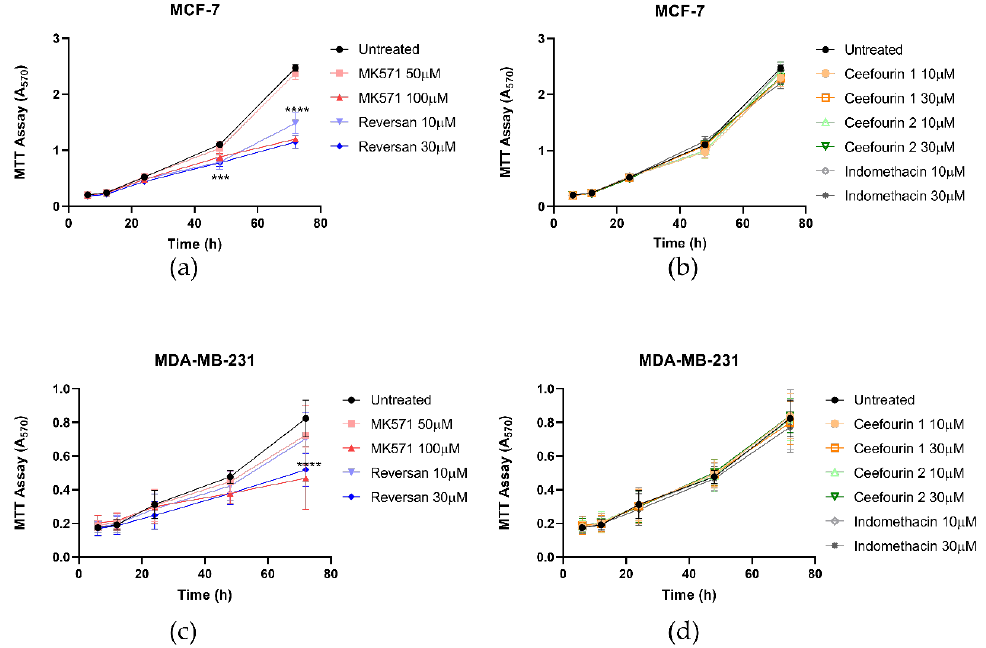
Figure 3. MK571 and Reversan affect the proliferation of breast cancer cells. Fifteen thousand MCF-7 cells ( a , b ) or 6000 MDA-MB-231 cells ( c , d ) were seeded in 24-well plates. After 4 h of culture, cells were treated with inhibitors, as detailed. Cell viability was assessed at 6, 12, 24, 48, and 72 h after treatment using an MTT assay and absorbance measured at 570 nm. Data are mean ± SD, n ≥ 6. Data were analyzed using a two-way ANOVA with a Dunnett’s post hoc test. *** p < 0.001 and **** p < 0.0001 significantly lower than the untreated sample.